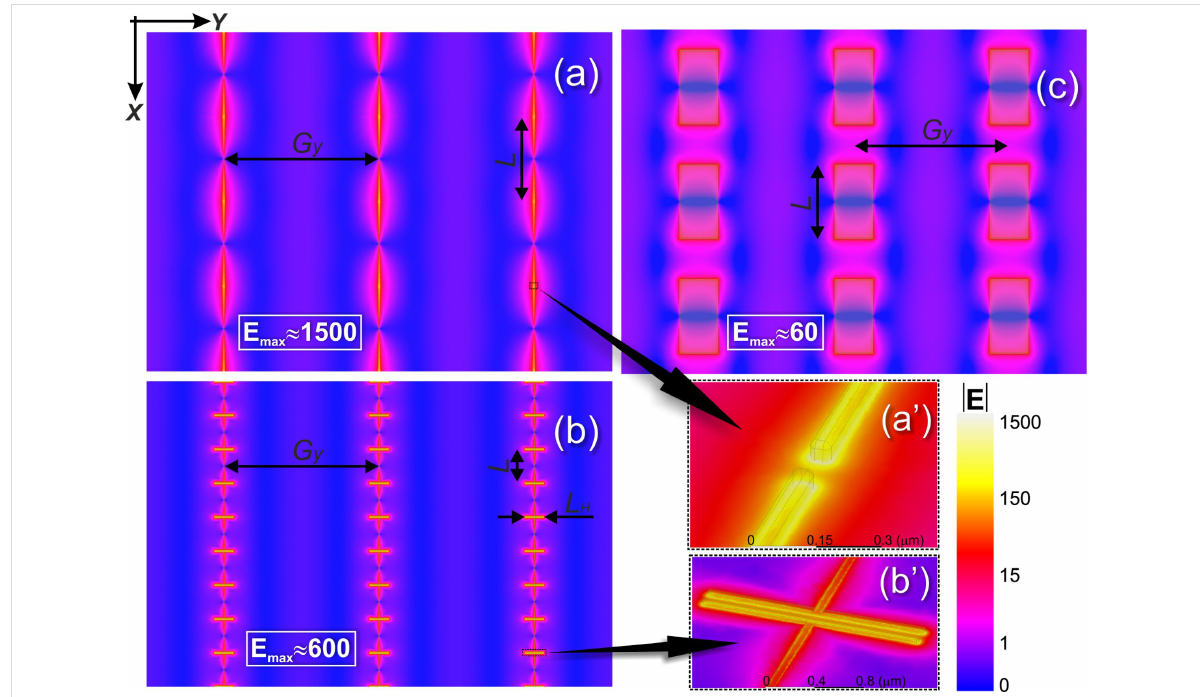
Figure 4: Distribution of the normalized LSPR electric field magnitude on top of the Si surface underlying the antenna arrays optimized for the LSPR energy of 190 cm − 1 : (a), (a’) linear nanoantennas, L = 8360 nm; (b), (b’) H-shaped nanoantennas, L = 3290 nm, L H = 1880 nm; (c) linear microan- tennas, L = 7.7 µm. The transverse period G y = 15380 nm coinciding with the 1st diffraction lobe onset point is chosen for all the cases. The E-field is normalized to that when the antenna array is removed from Si surface, thereby displaying relative antenna-induced field amplification. The framed numbers indicate the peak values. Normal excitation, E 0 II X